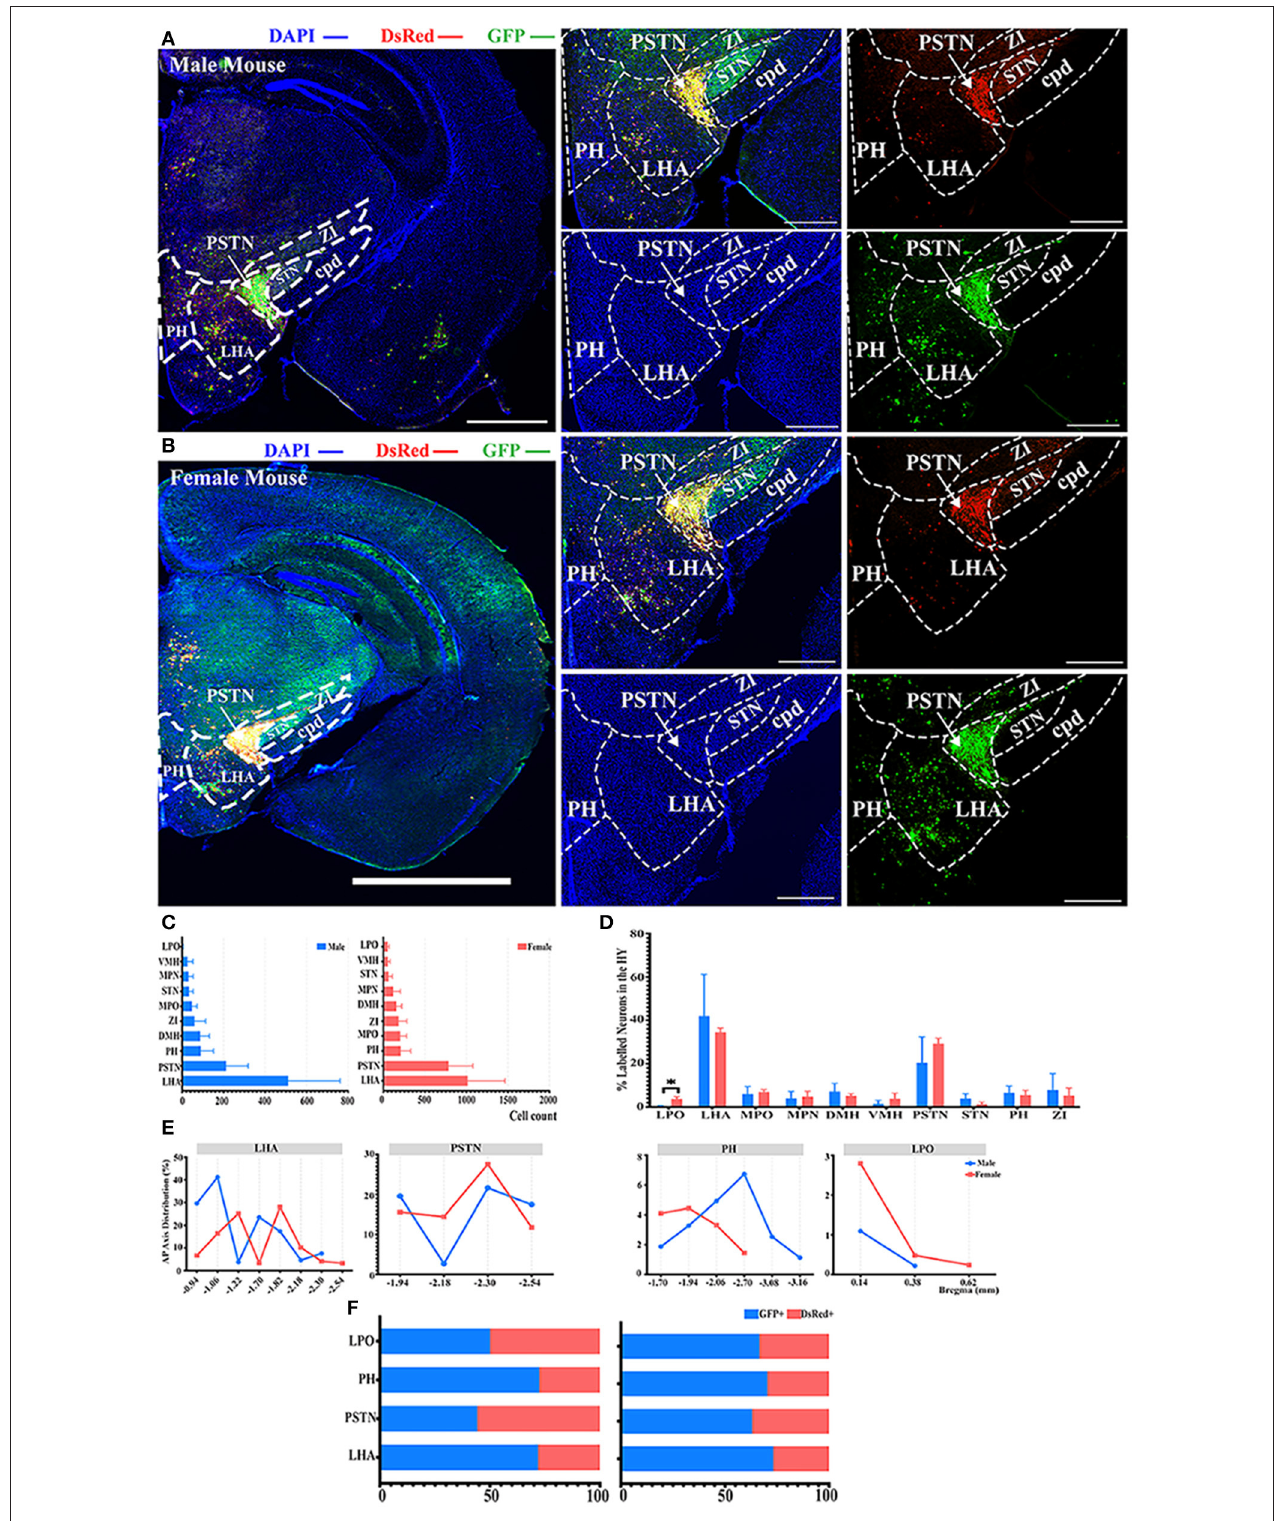
FIGURE 3 | Distribution patterns of labeled neurons in HY. (A,B) Representative images showing labeled neurons from the mouse ipsilateral HY to the ELGs. Scale bar: 1mm (left lower magnification images) and 200 µ m (for right higher magnification images); ( A , male; B , female). (C) Numbers of the labeled neurons (GFP + and dsRed + ) in different subregions of HY (left, male; right, female). (D) Distribution of the labeled neurons within HY (significant difference labeled on the bar top, otherwise n.s.). (E) Distribution patterns of the labeled neurons along the AP axis in different subregions of HY. (F) Distribution of GFP + and dsRed + within subregions of HY (left, male; right, female). GFP + , PRV-GFP positive neurons; dsRed + , PRV-dsRed positive neurons., n.s., no significant difference; * p < 0.05.